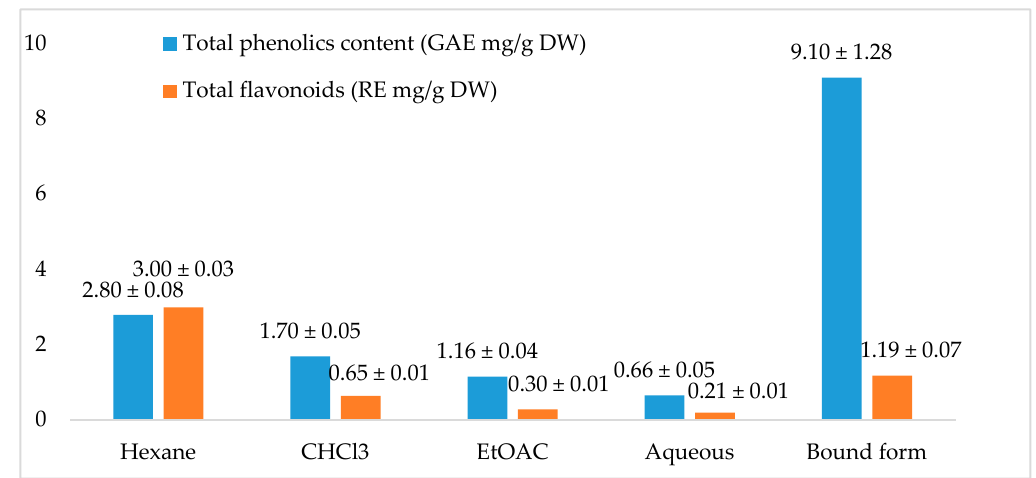
Figure 1. Total phenolic and flavonoid content in extracts of plant parts of Phal. Sogo Yukidian “V3” cultivar. Values represent each mean ± standard deviation (SD) ( p < 0.05) ( n = 3); GAE: gallic acid equivalent; RE: rutin equivalent; DW: dry weight.